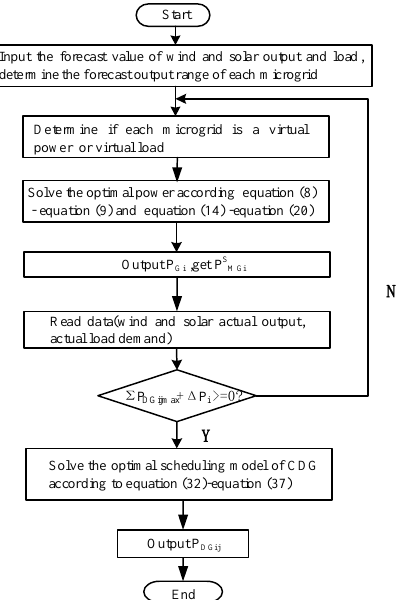
Figure 4. Solving flow chart of bi-level optimal scheduling model.